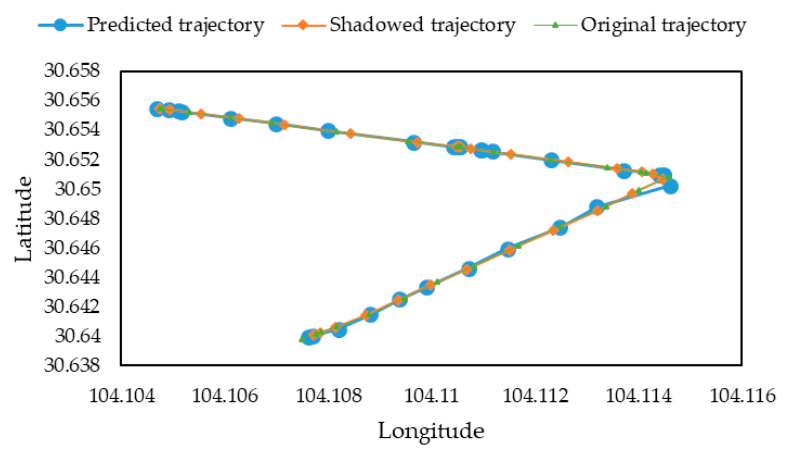
Figure 17. The original, shadowed, and predicted trajectories of the taxi for the marked (b).